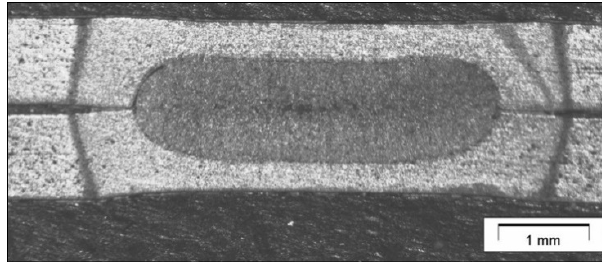
Figure 10. Image of the 18th experiment (CCF 18).